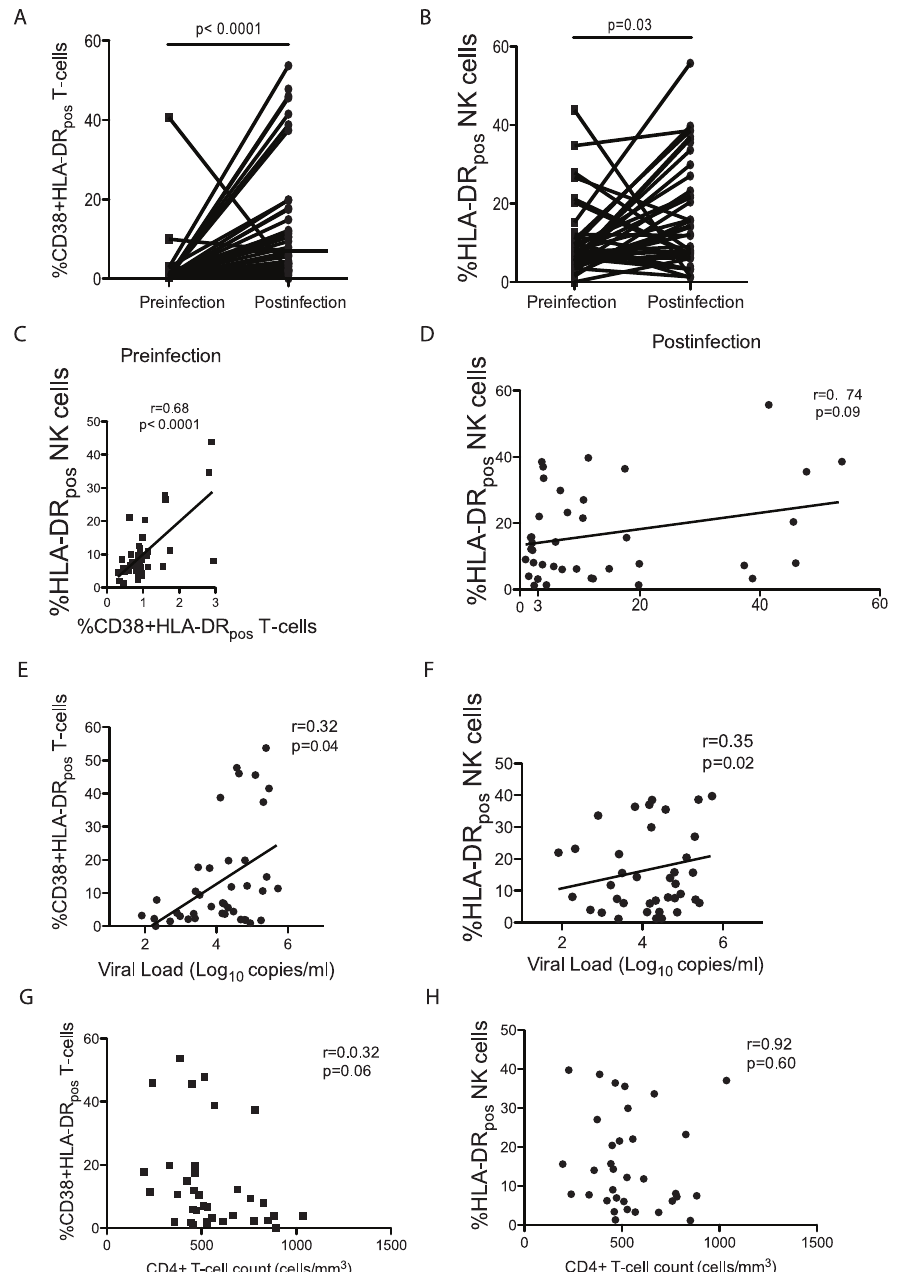
Figure 1. Primary HIV-1 infection was associated with differential T-cell and NK-cell activation. T-cells (A) and NK cells (B) were activated following HIV infection. The proportion of activated T-cells and NK cells was significantly correlated before (C), but not following HIV-1 infection (D). In contrast, during primary infection, both T-cell (E) and NK-cell (F) activation were positively correlated with HIV viral load (log 10 copies/ml) but not CD4 + T-cell counts (G and H